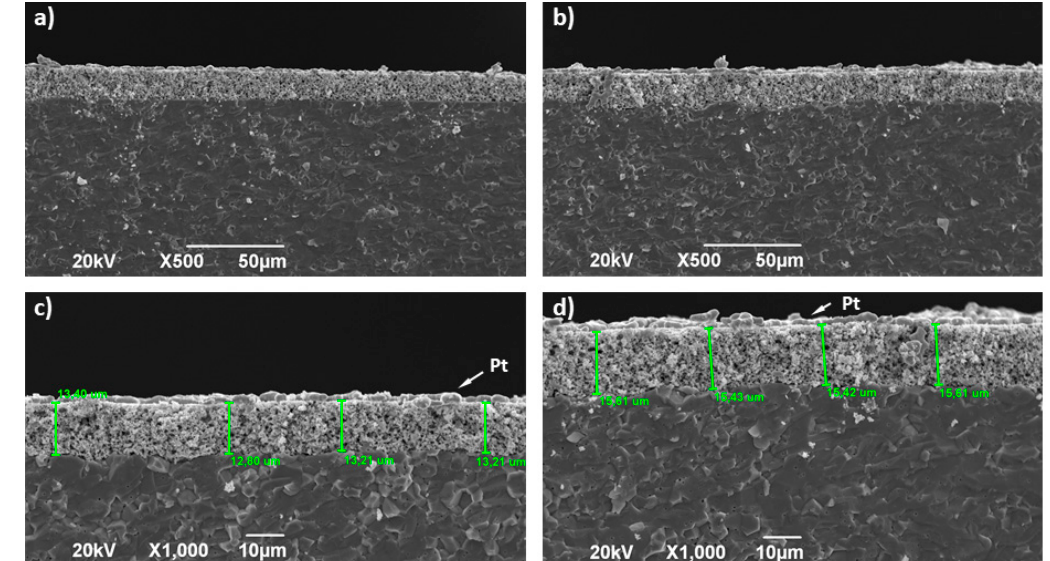
Figure 7. SEM micrographs of La 2 − x NiTiO 6 −δ :YSZ composite electrodes and interface with YSZ electrolyte ( a , b ) ×500 and ( c , d ) ×1000 for La 2 NiTiO 6 −δ and La 1.8 NiTiO 6 −δ , respectively.